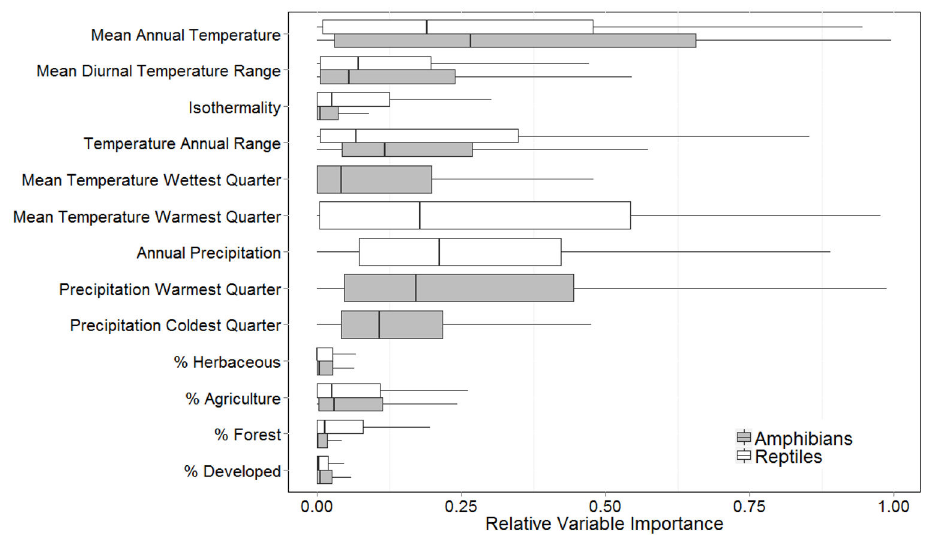
Figure 2. Box-and-whisker plot of relative importance of variables used to model amphibian and reptile distributions; computation of relative variable importance is described in the Methods